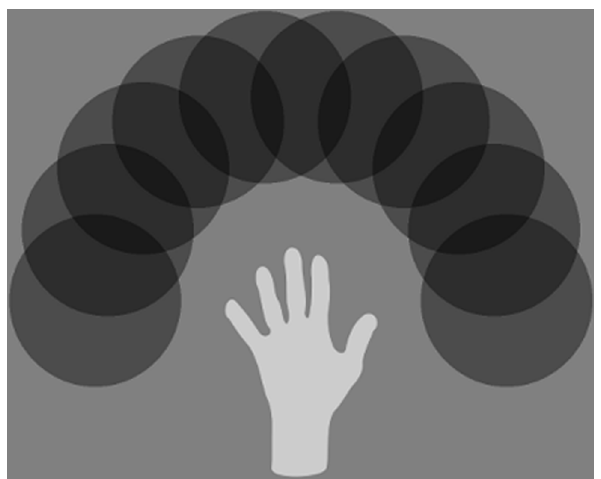
Figure 7. Image of the hand with 10 target locations. With 10 target locations around the hand, the targets are highly overlapping. In this case, the targets begin to form an effective continuum of hand- centred locations.